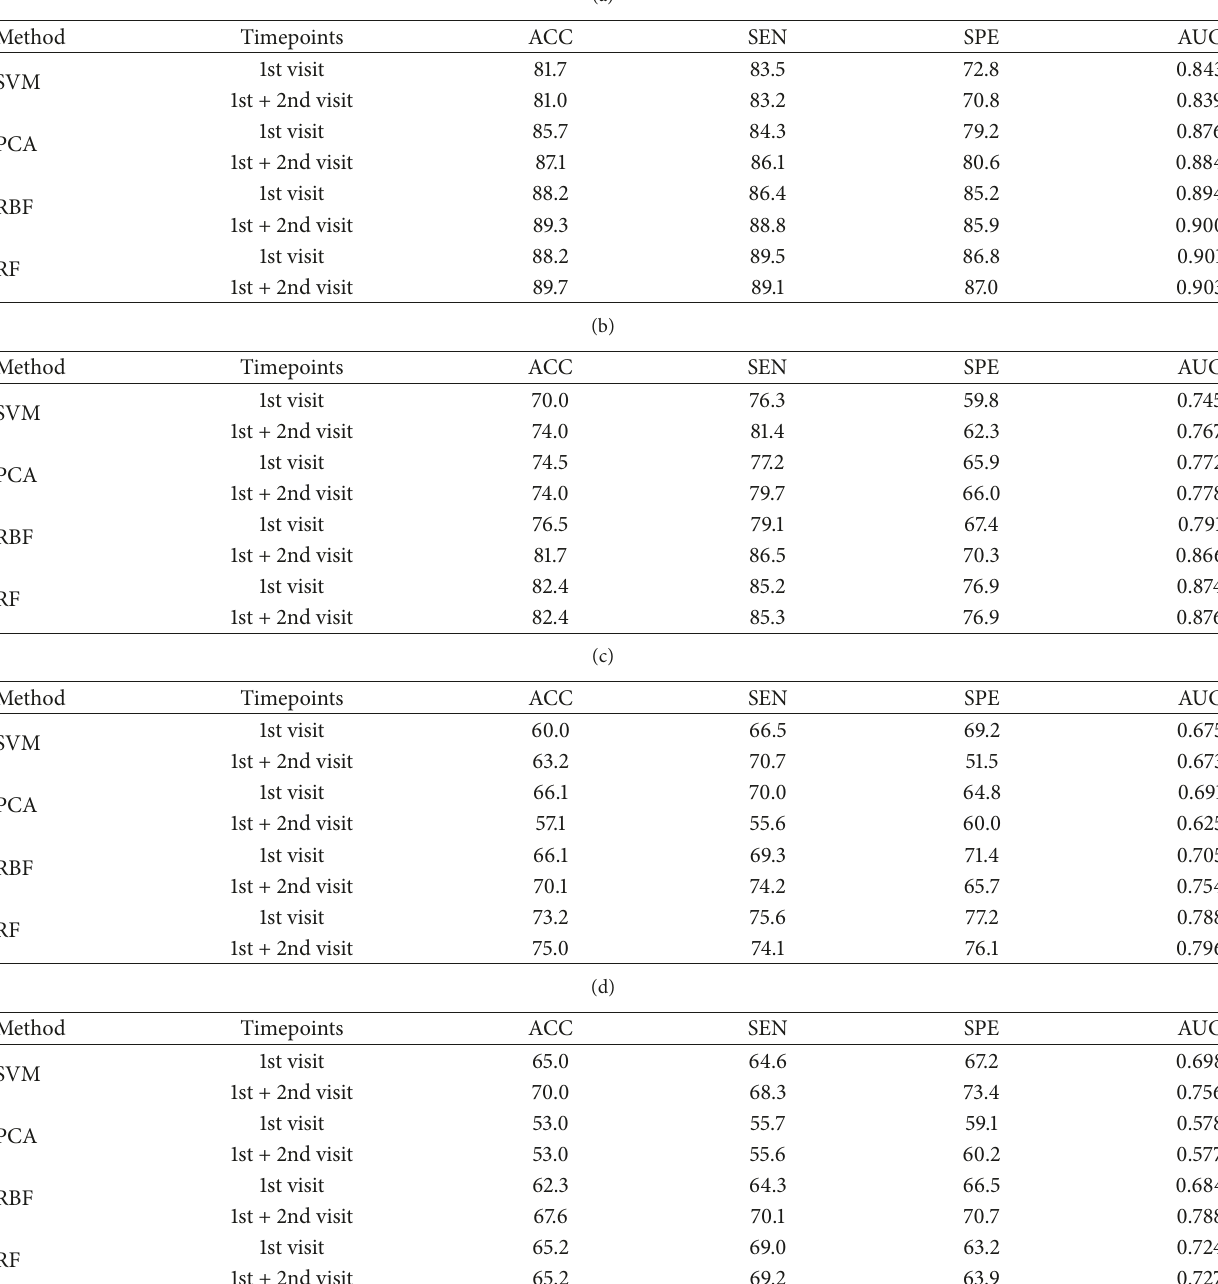
Table 3: Classification performance in multiregion approaches (SVM, PCA, RBF, and RF), evaluating accuracy (ACC), sensitivity (SEN), specificity (SPE), and area under the curve (AUC). (a) AD versus NC; (b) AD versus EMCI; (c) AD versus LMCI; (d) EMCI versus